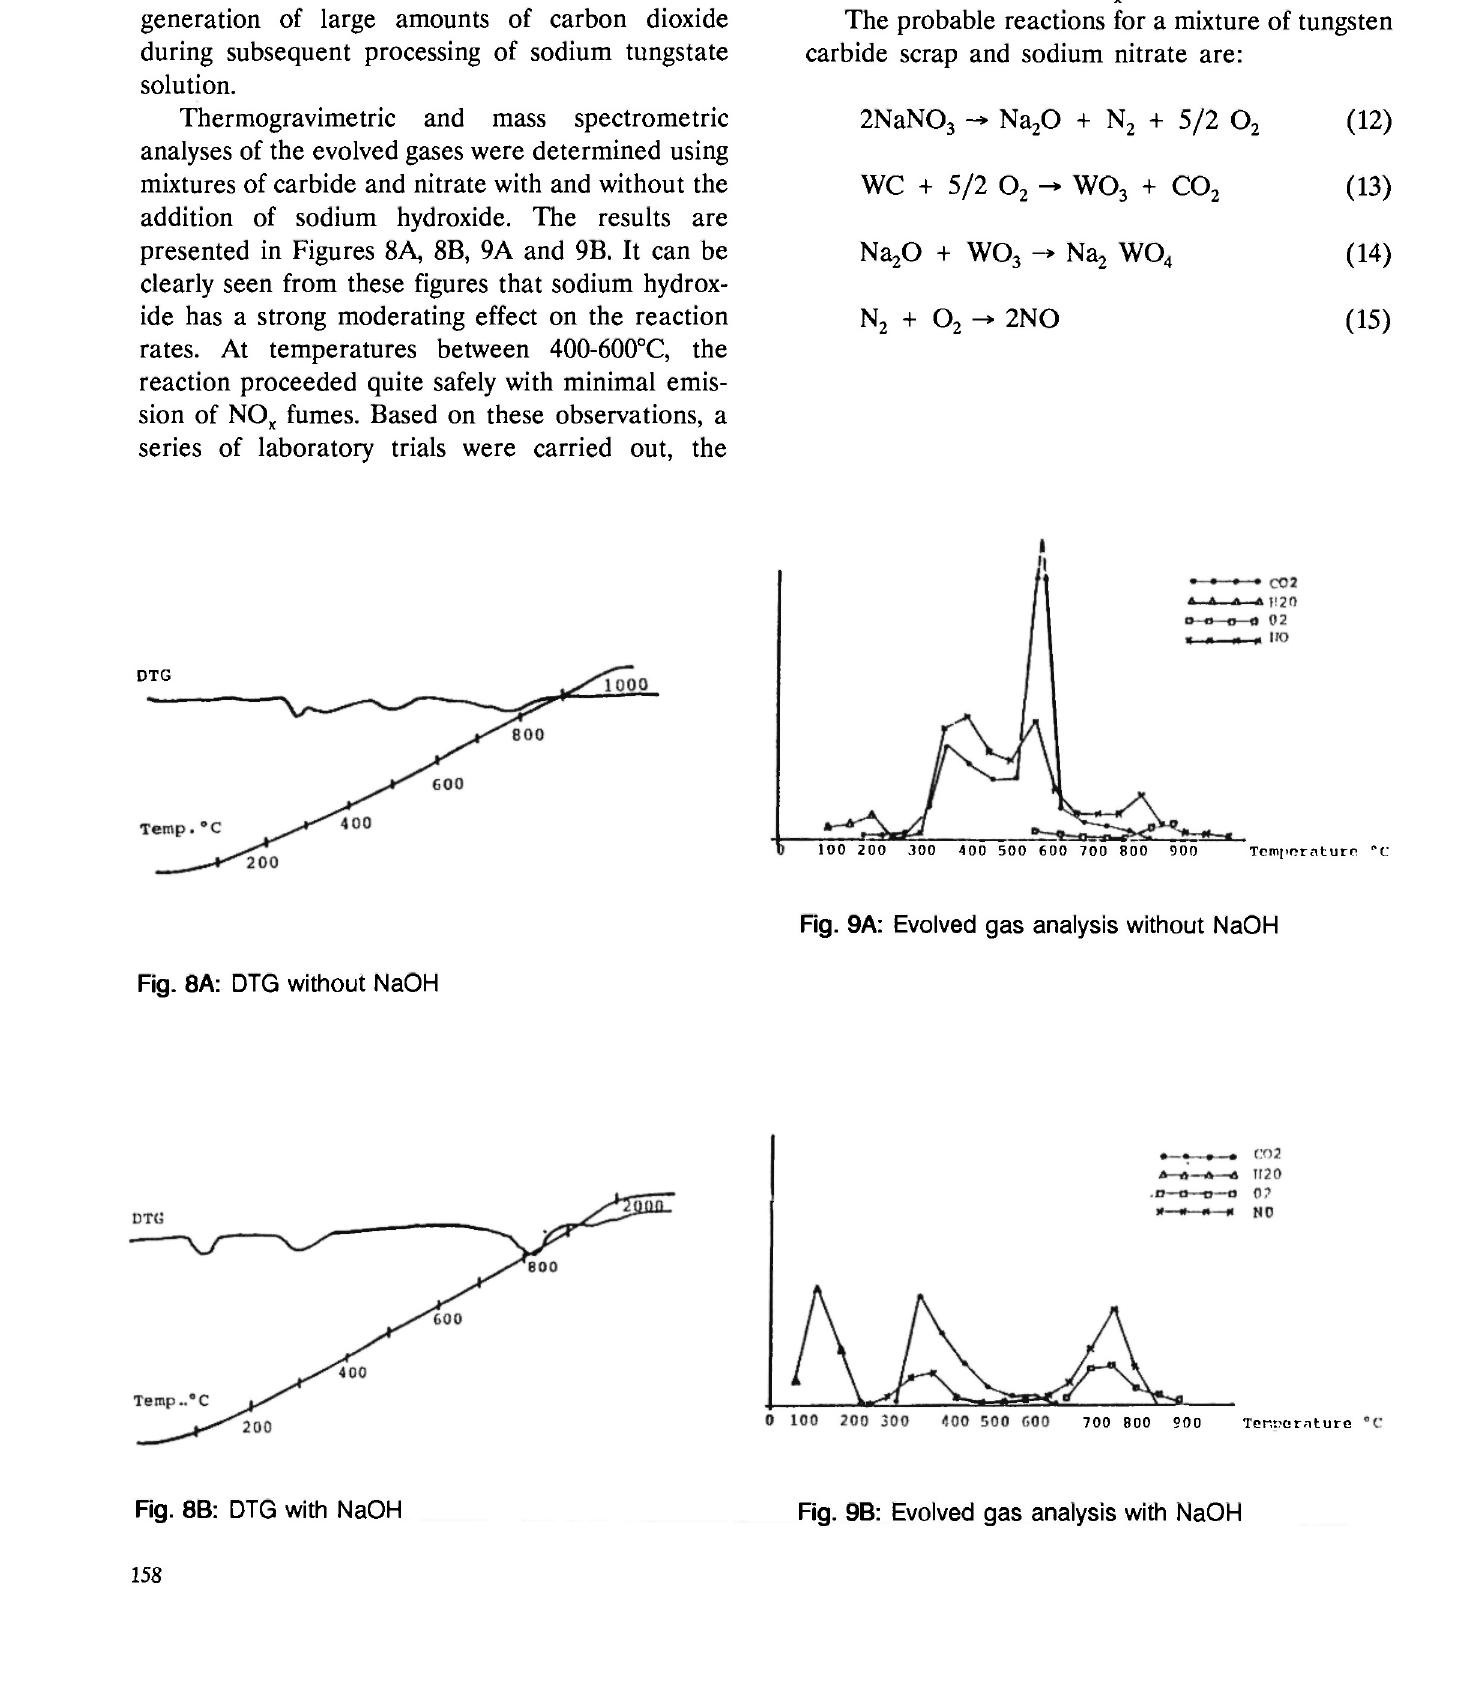
Fig. 8B: DTG with NaOH Fig. 9B: Evolved gas analysis with